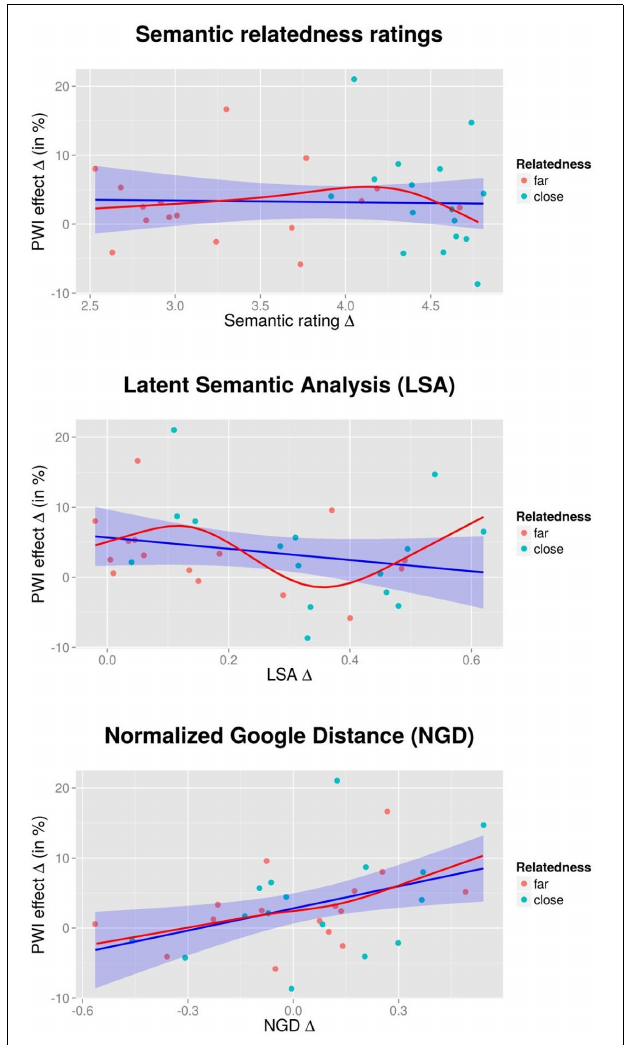
FIGURE 3 | Experiment 2—Degree of semantic interference (in percent), dependent on semantic relatedness ratings (top panel), Latent Semantic Analysis scores (LSA; middle panel), and Normalized Google Distance scores (NGD; bottom panel). Dots represent individual target-distractor combinations. The blue line corresponds to a regression between the two variables with linear terms; the red line corresponds to an analysis using restricted cubic splines (see text for